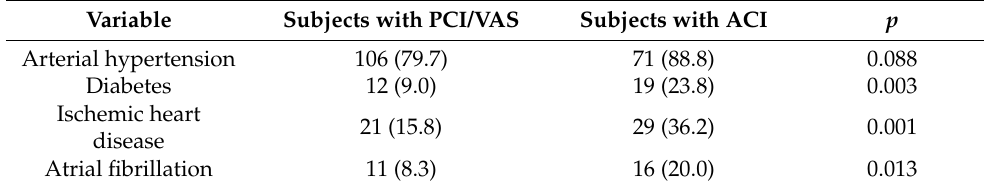
Table 3. The prevalence of vascular risk factors in subjects with posterior circulation infarction/vertebral artery syndrome and anterior circulation Table 2. Risk of PCI/VAS by degree of vertebral artery hypoplasia, OR (95% CI), p.